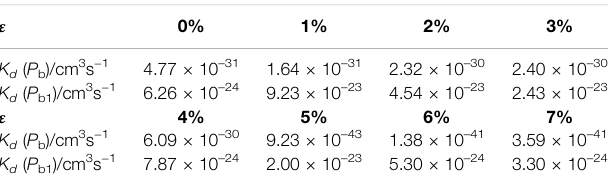
TABLE 10 | Depassivation reaction rates of P b and P b1 defects under tensile strains at 300